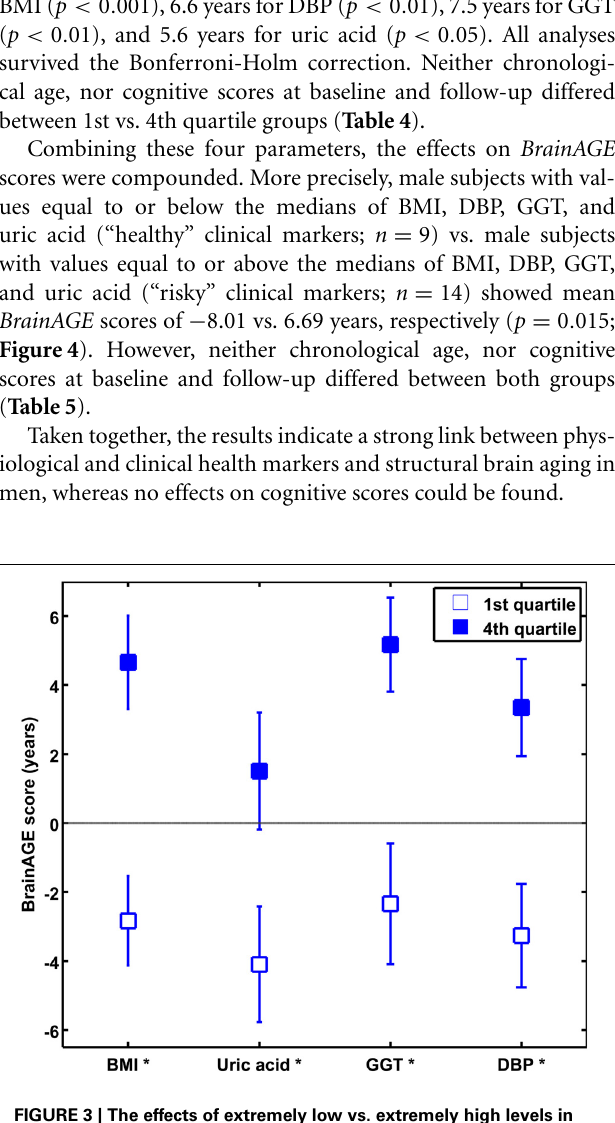
FIGURE 3 | The effects of extremely low vs. extremely high levels in clinical markers on BrainAGE in the male sample. Mean BrainAGE scores of male subjects in the 1st (plain) and the 4th quartiles (filled squares) of the most significant physiological and clinical chemistry parameters (i.e., BMI, uric acid, GGT, and DBP). Error bars depict the standard error of the mean (SEM). [ ∗ p < 0 . 05 after Bonferroni-Holm